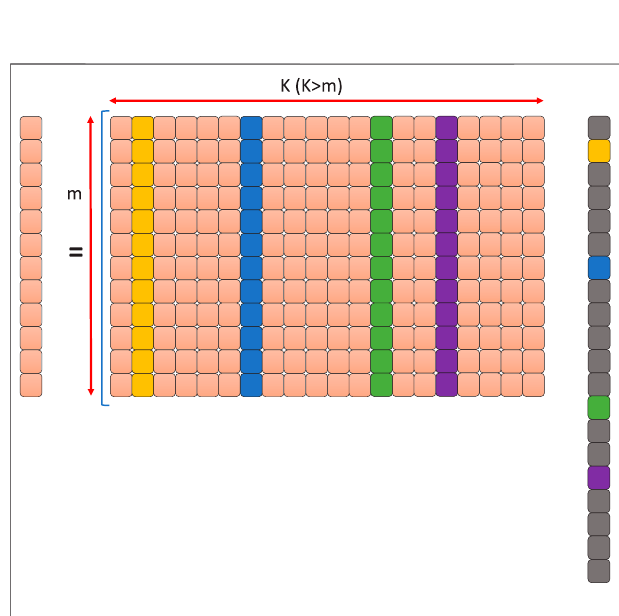
FIGURE 1 | Basic model of sparse representation